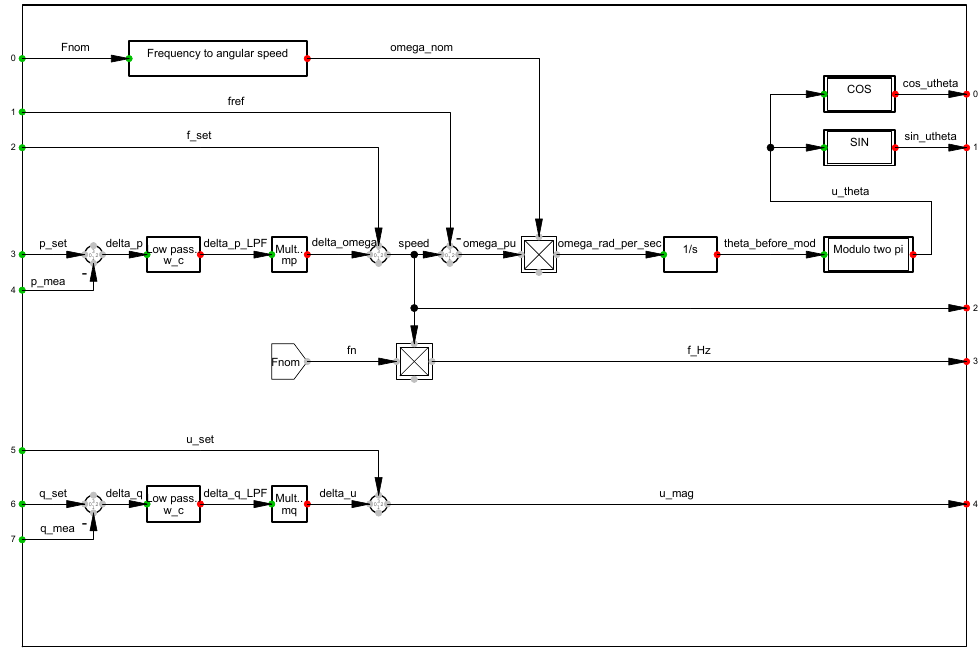
Figure A1. Droop control. See Section 4.1 for details.